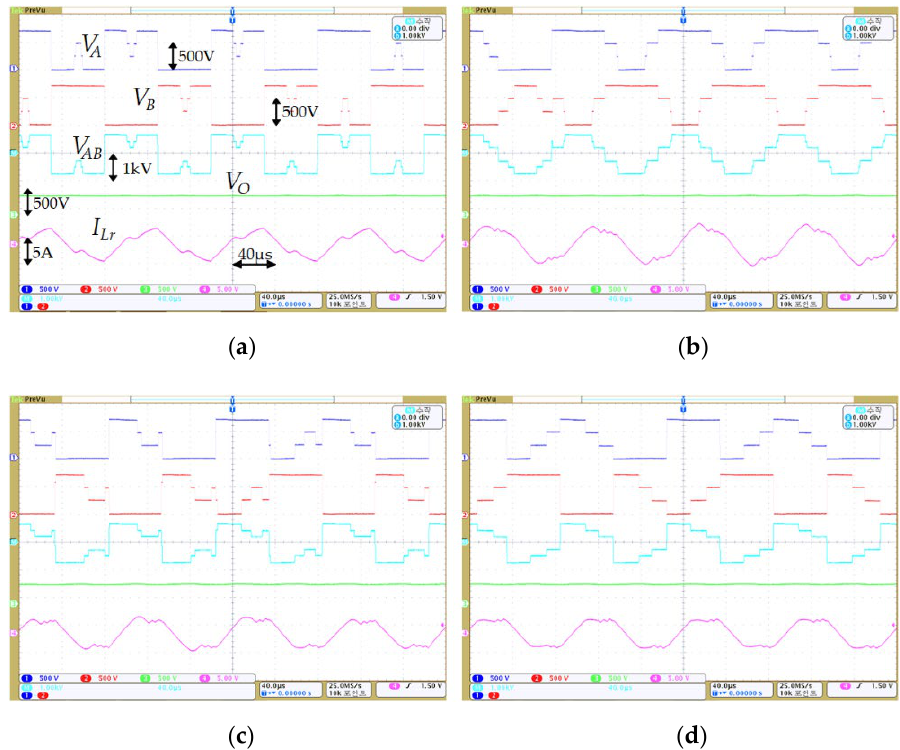
Figure 21. Experimental results for the ( a ) middle, ( b ) edge, ( c ) rear, and ( d ) end sags when P O = 500 W.